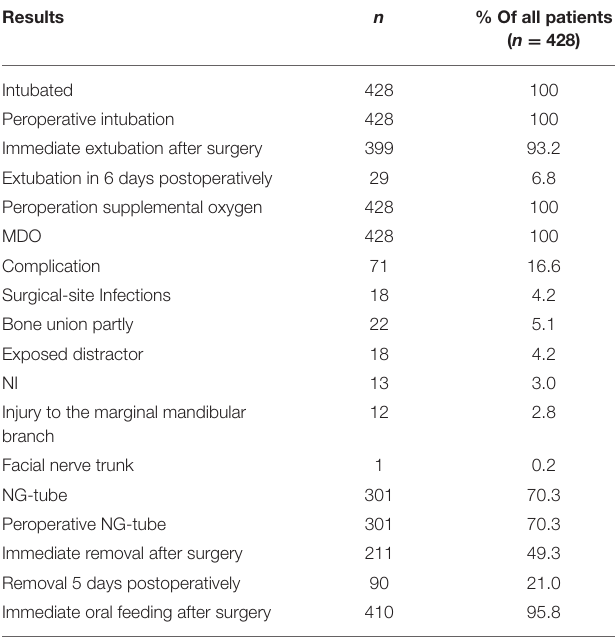
TABLE 2 | Treatment results of all patients.